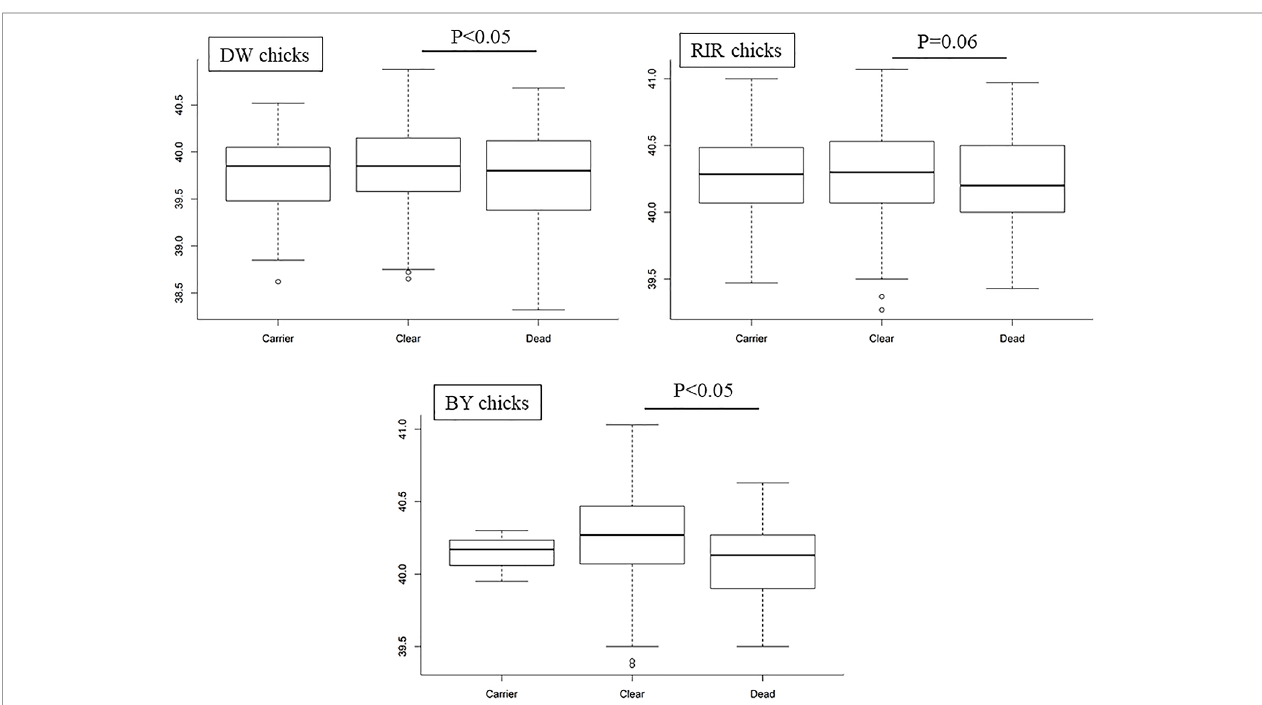
FIGURE 3 | Boxplots of temperature from different Salmonella Pullorum resistance; P represents the p-value between Dead and Clear